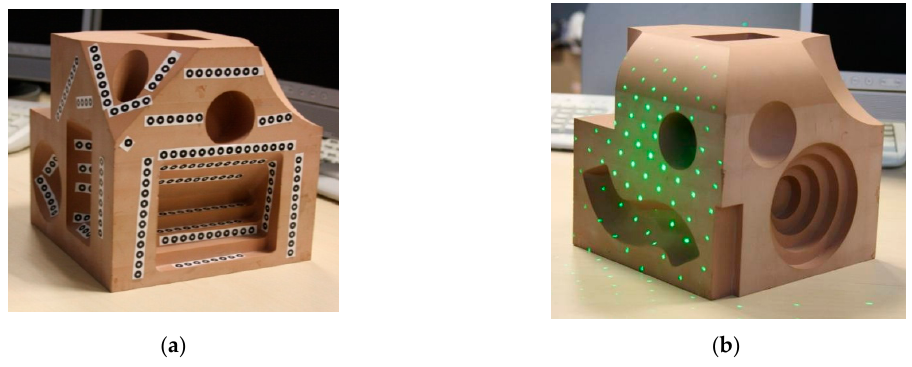
Figure 4. Physical marks used in marker-based stereo vision. ( a ) Stickers; ( b ) Laser points.